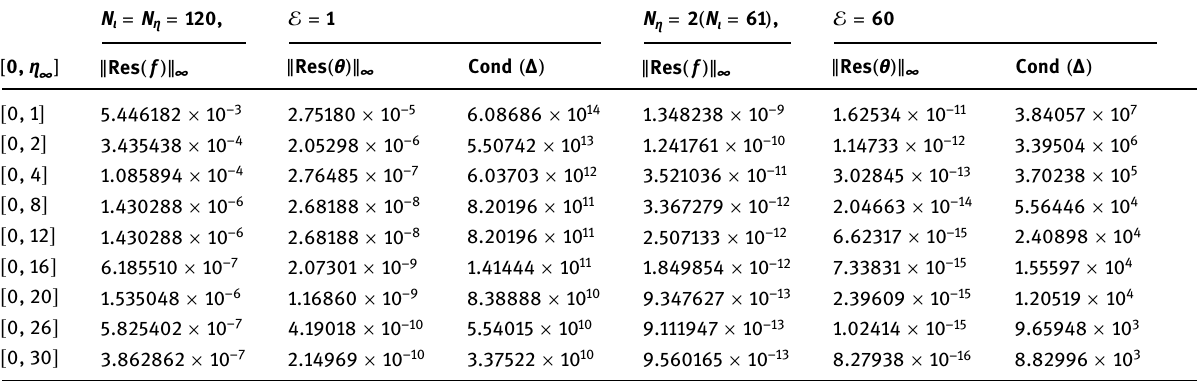
Table 6: Condition numbers and residual error values when the size of domains is varied